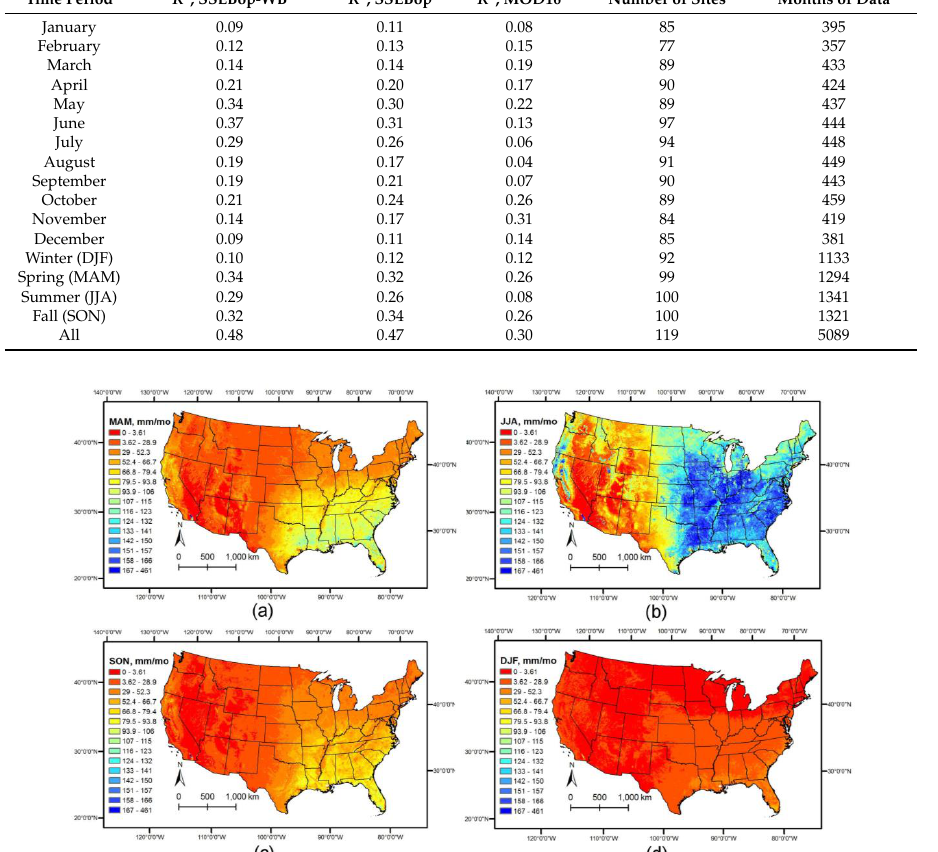
Table 1. Correlations between AmeriFlux data and the three ET methods by month and season. All correlations are statistically significant with p < 0.01.